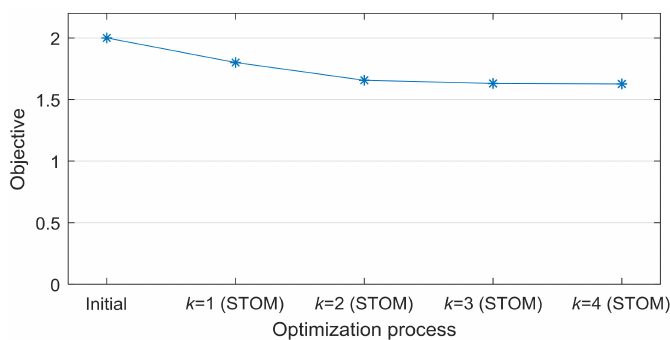
Figure 11. Optimization process of the sequential Taguchi optimization